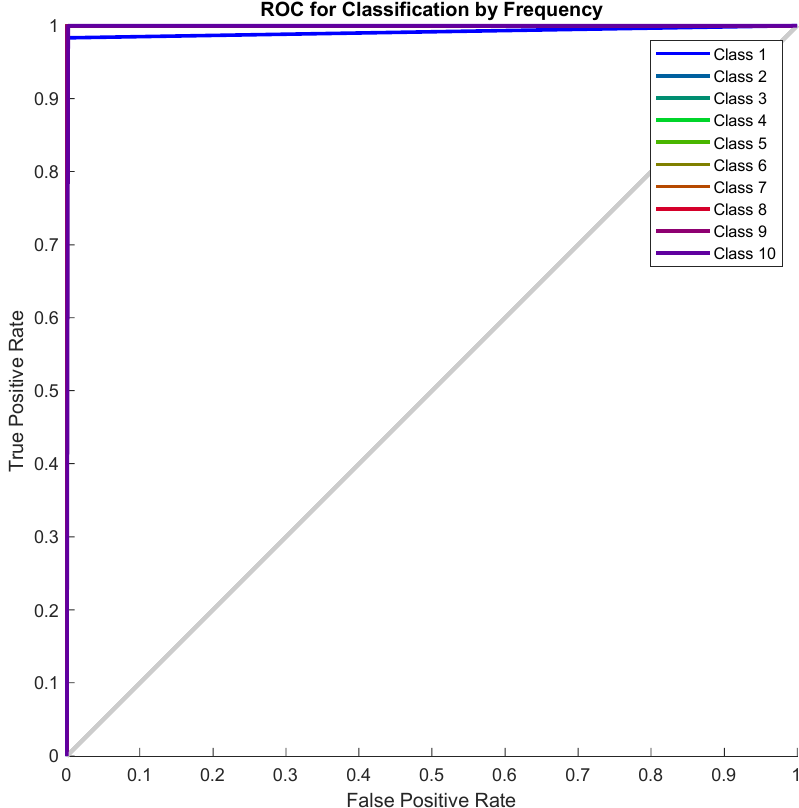
Figure 35. ROC for noisy LFM by 2D-CNN, when epoch equal 30. Table 3. Training parameters of noisy LFM dataset. Best performance is shown in